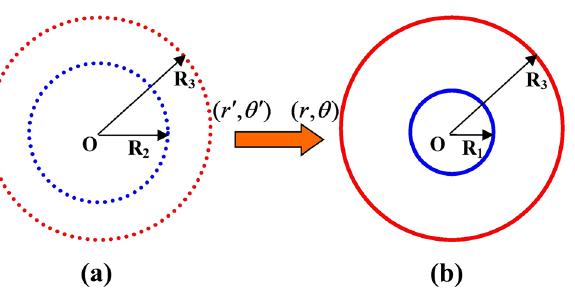
) 2 r − R 1 ( R 2 R 2 R 1 r ; ( c ) impedance function = −